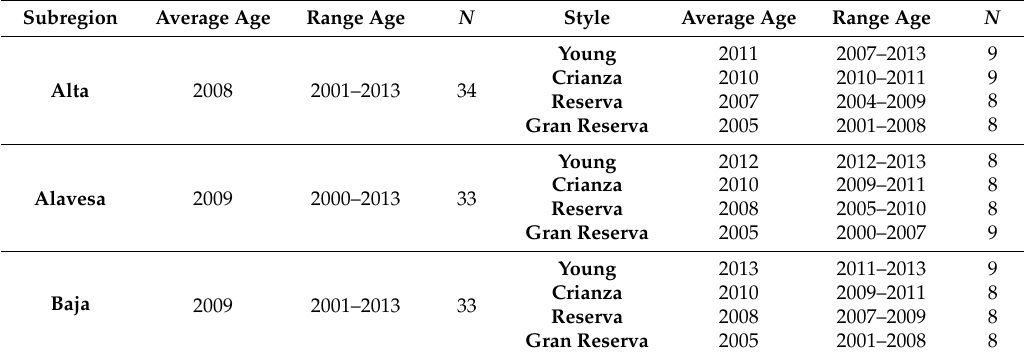
Table 3. Rioja wines by subregion and style.